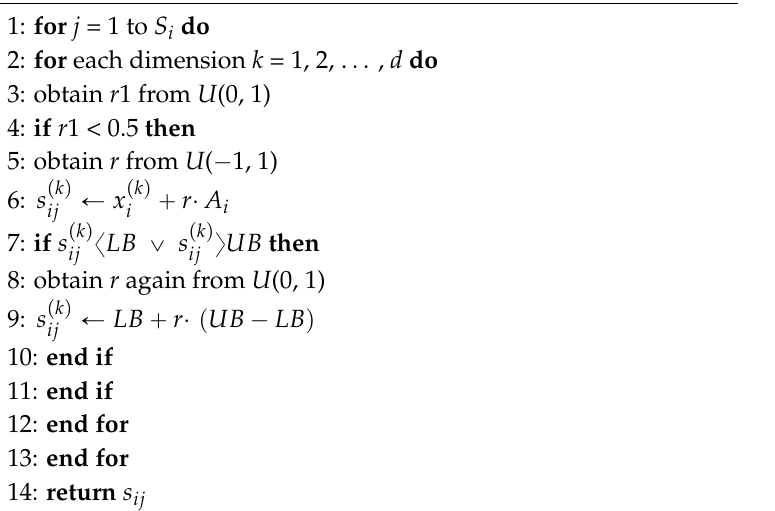
Algorithm 1 Generating Explosion Sparks